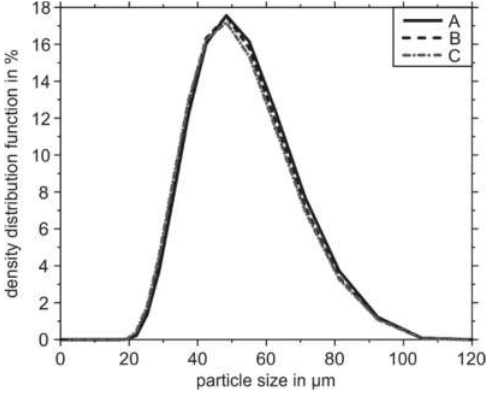
Figure 2. Particle size density distribution functions.